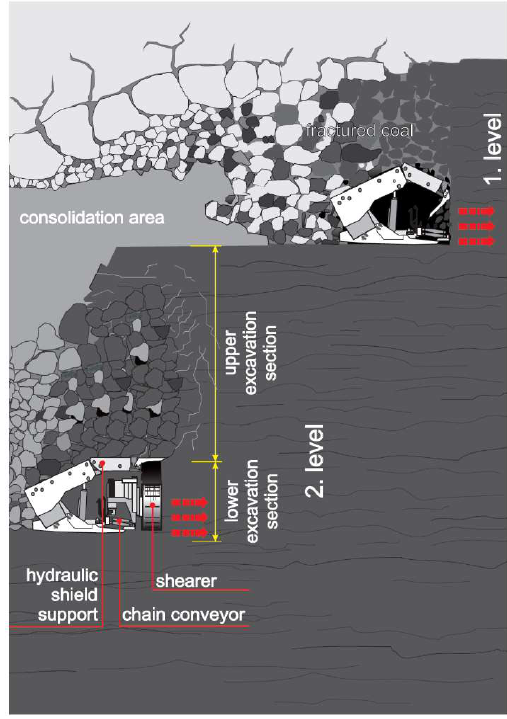
Figure 4. State of the art excavation scheme of VMM [2].